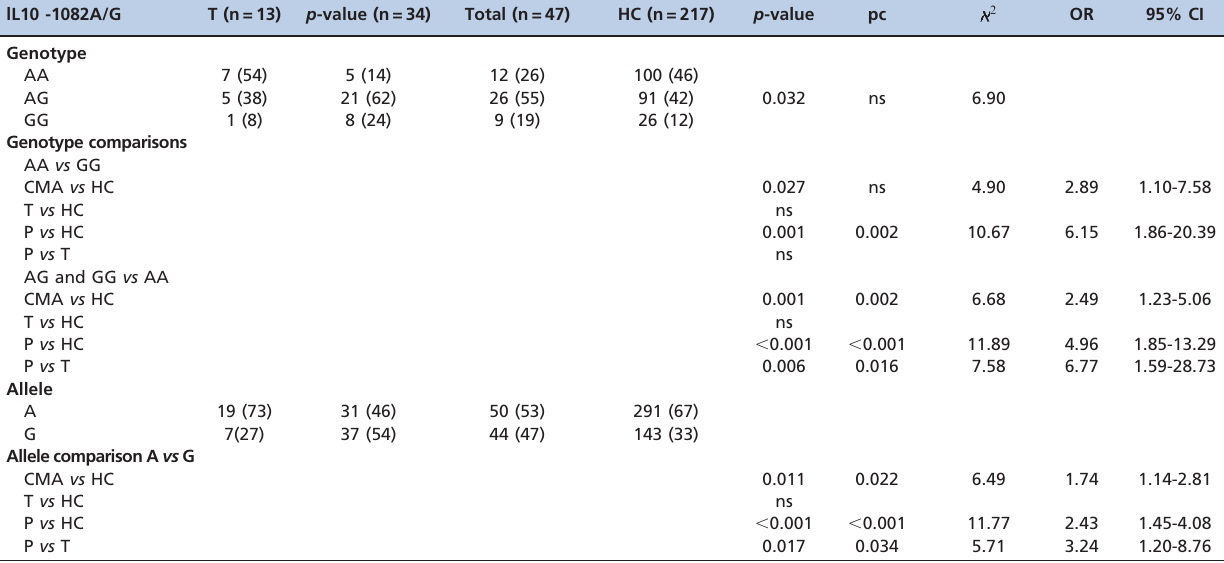
Table 2 - Genotype and allele frequency of IL10 -1082 A/G polymorphism in children with cow’s milk allergy and in healthy controls (HCs).